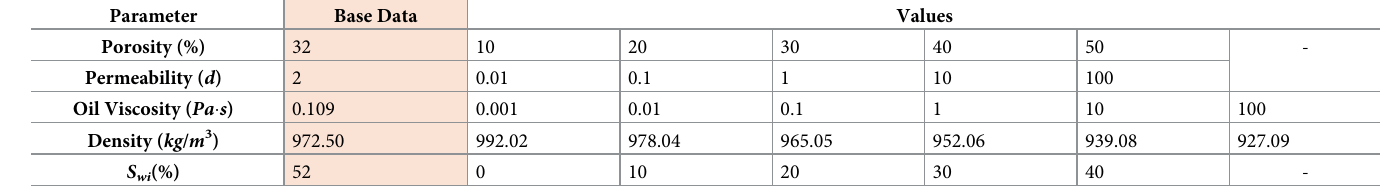
Table 2. Summary of numerical experiments considered for the sensitivity analysis. The base parameters for each numerical experiment were kept constant to those presented later in Table 3.